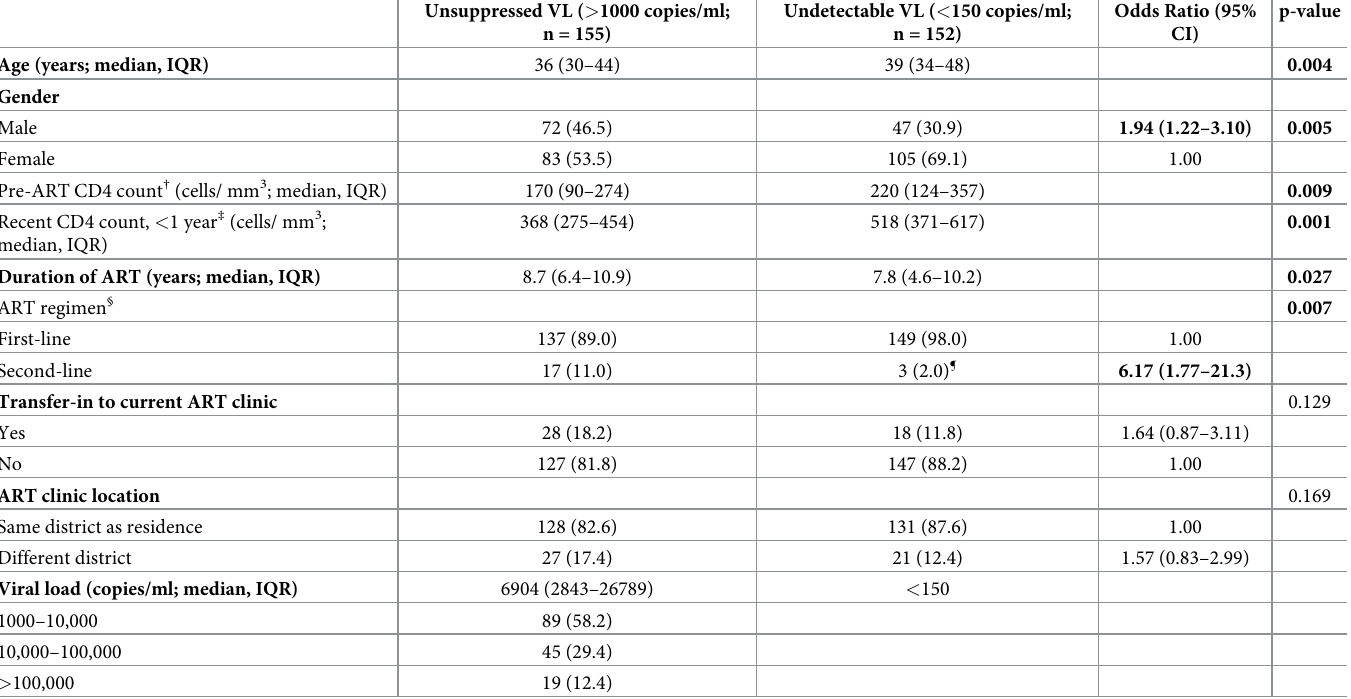
Table 1. Comparison of demographic and medical characteristics of study participants on ART with lack of virological suppression and with undetectable viral load.